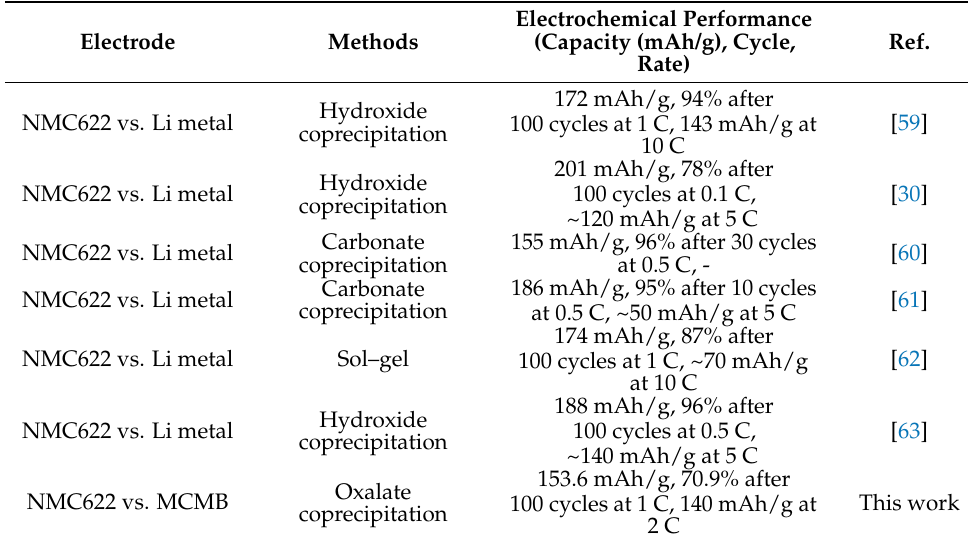
Figure 10. Cycle-ability analysis of; ( a ) NMC 442, NMC 532, and NMC 622 at 1 C’ for 50 cycles, ( b ) NMC622 at 1 C’ for 100 cycles. Table 7. State-of-the-art performance metrics of